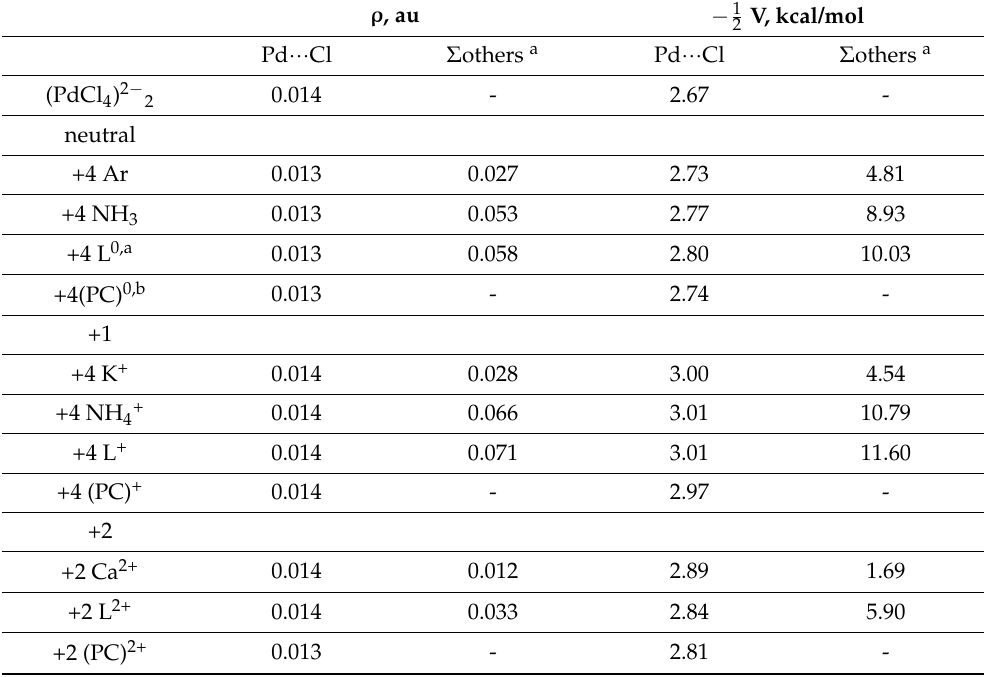
Table 2. AIM properties of bond critical points between subunits in complexes. ρ ,